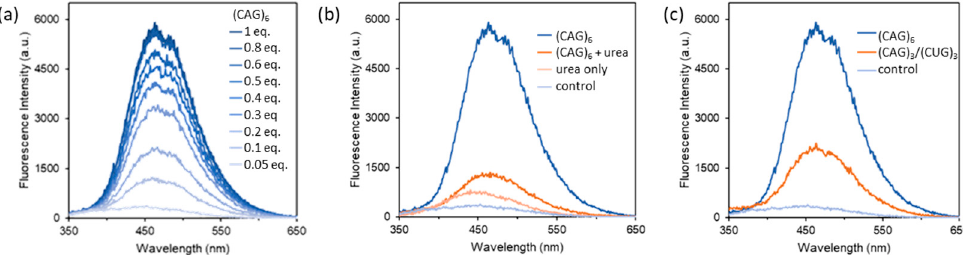
Figure 4. Fluorescence spectra of 10 µM DB-TPE ( λ ex = 300 nm) in the presence of ( a ) increasing amount of (CAG) 6 RNA from 0.05 to 1 eq., ( b ) 1 eq. of (CAG) 6 RNA denatured by 1 M urea, and ( c ) 1 eq. of complementary (CAG) 3 /(CUG) 3 RNA duplex.